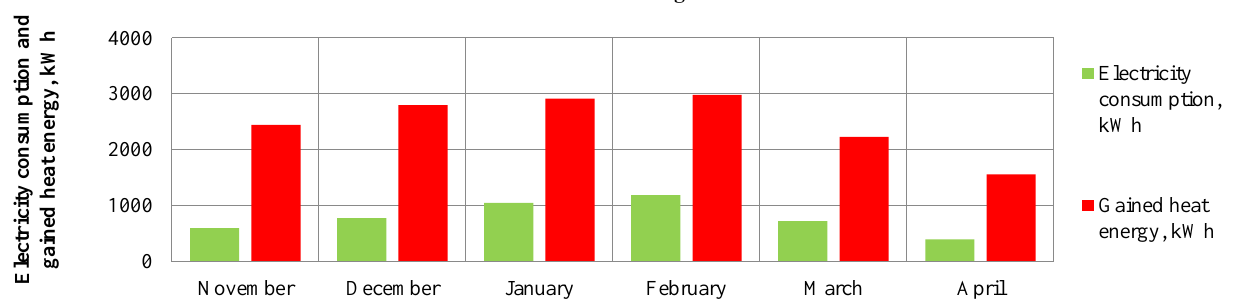
Fig. 3. Gained heat energy and electricity consumption results for the example residential building of 150 m 2 in season